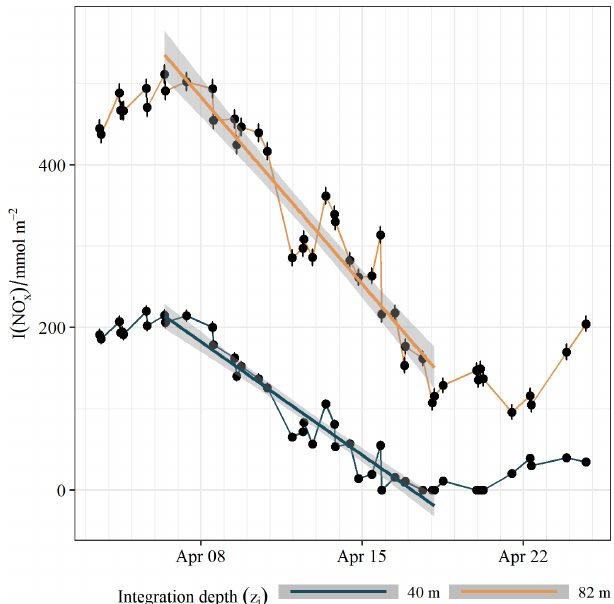
Figure 3. Water-column-integrated nitrate inventory. Points show inventory values with error bars indicating standard uncertainty. Lines indicate a linear model fit, with the shaded grey area signi- fying a 95% confidence interval.